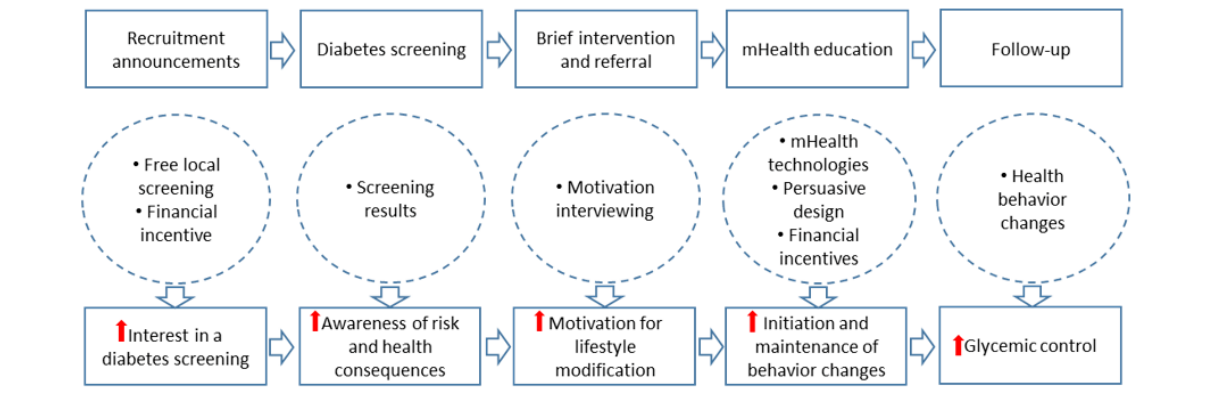
Figure 1. Conceptual Framework of the Diabetes Screening and mHealth Education Program.